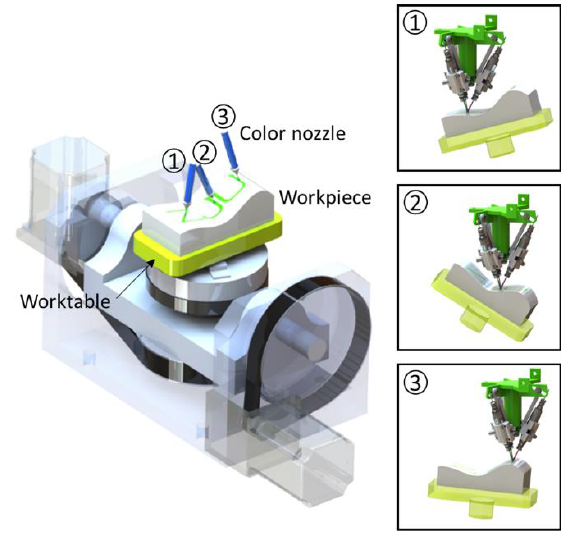
Figure 4. Normal direction printing mode. ① a posture when printing Letter Z, ② a posture when printing Letter J, ③ a posture when printing Letter U.